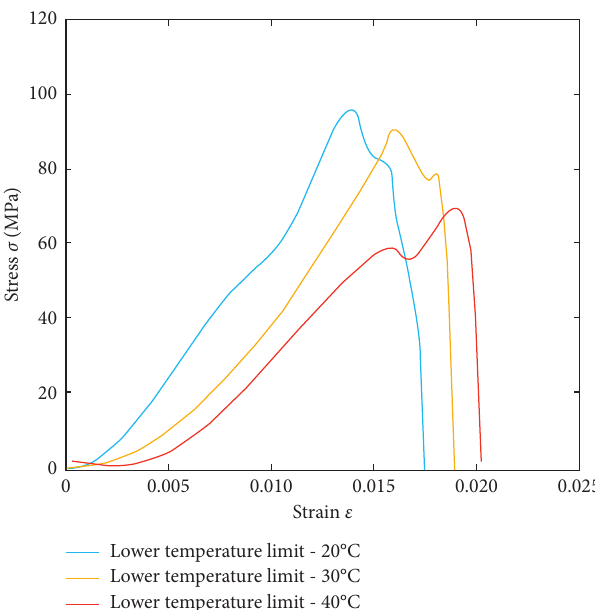
Figure 3: Typical stress-strain